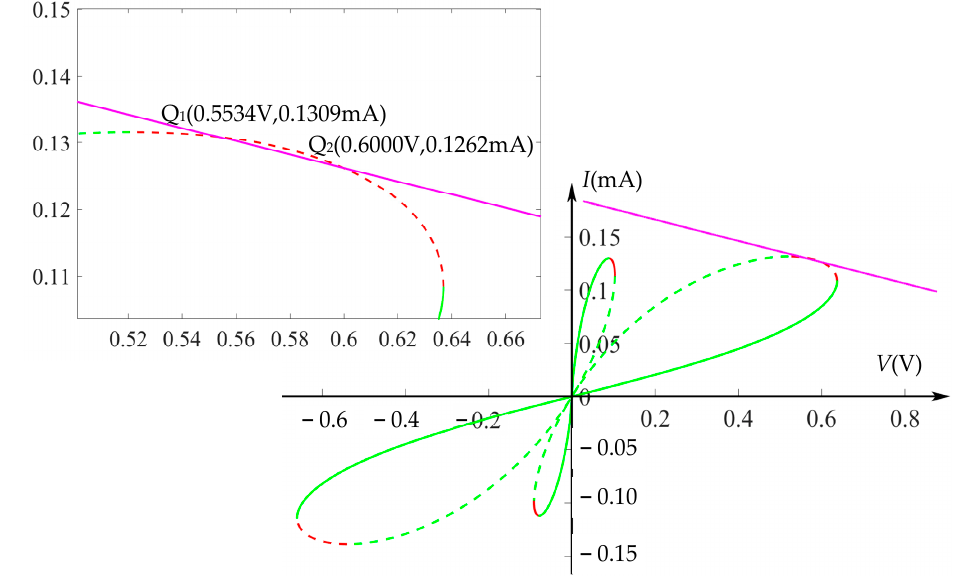
Figure 8. ( a ) Parallel capacitance and ( b ) series resistance of locally active memristor oscillation circuit.